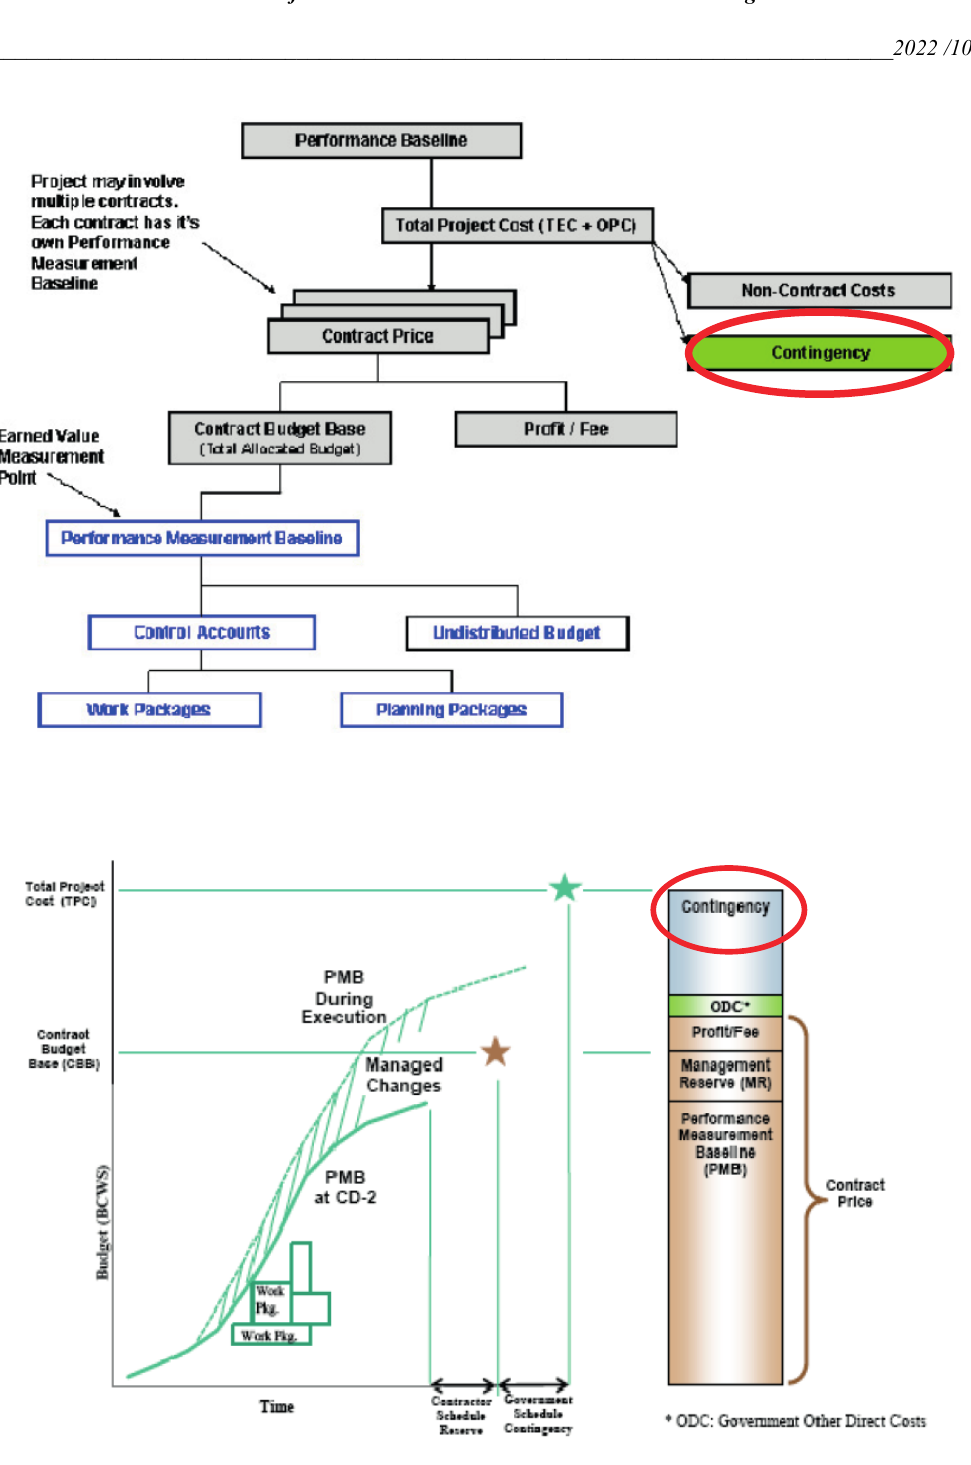
Fig. 7. Contents of a project Performance Baseline (Project Budget Allocations) & Typical project Performance Baseline, including cost and schedule ( DOE, 2015a: